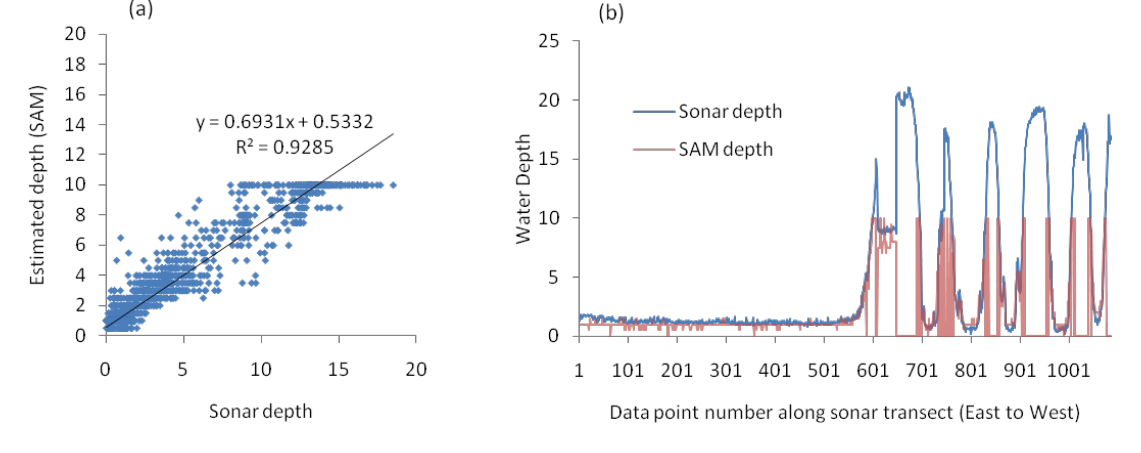
Figure 8. ( a ) The classified image of Heron Reef bathymetry was validated using boat-based sonar measurements. The estimated water depth from the classified image was plotted against the sonar depth measurements, and showed a high correspondence, with an R 2 value of 0.9285. The maximum depth modelled in the in-situ library, and therefore the maximum estimated depth, was 10.0 m; ( b ) Water depths along the boat-based sonar track and estimated from the classified image, running from east to west, beginning to the West of Heron Island (shown in Figure 1). Values of zero refer to unclassified areas in the classified image, which was only classified to depths of 10